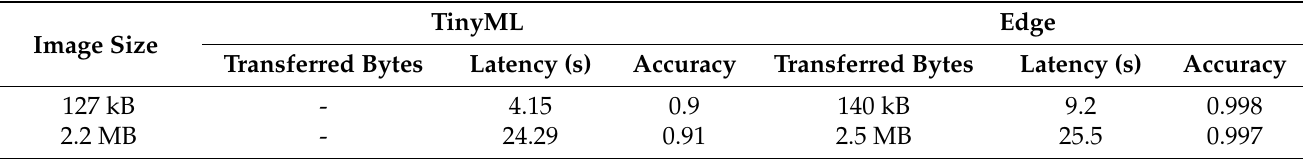
Table 5. TinyML vs.